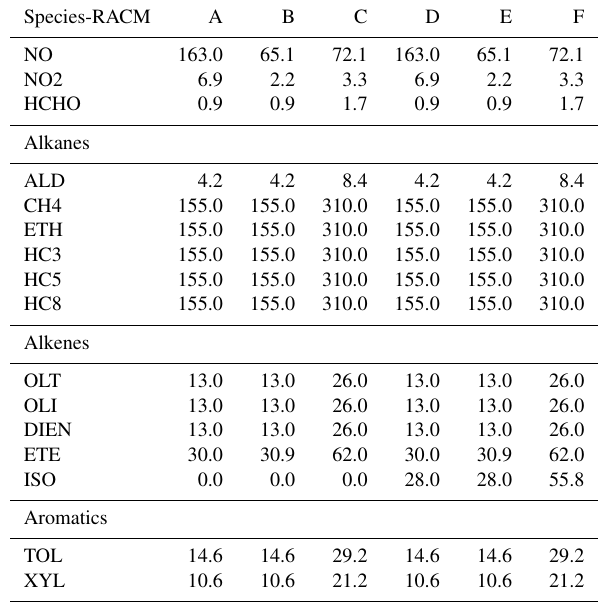
Table 1. Initial species mixing ratios (ppbv) for RACM as deduced from Heard et al. (1998). Water content is 10 7 ppbv, CO content is 2310ppbv. Pressure is fixed at 1atm, and temperature at 298 K. VOC / NO x ratios (methane not included) for cases A–F are 4.2, 10.7, 19.1, 4.4, 11.1, and